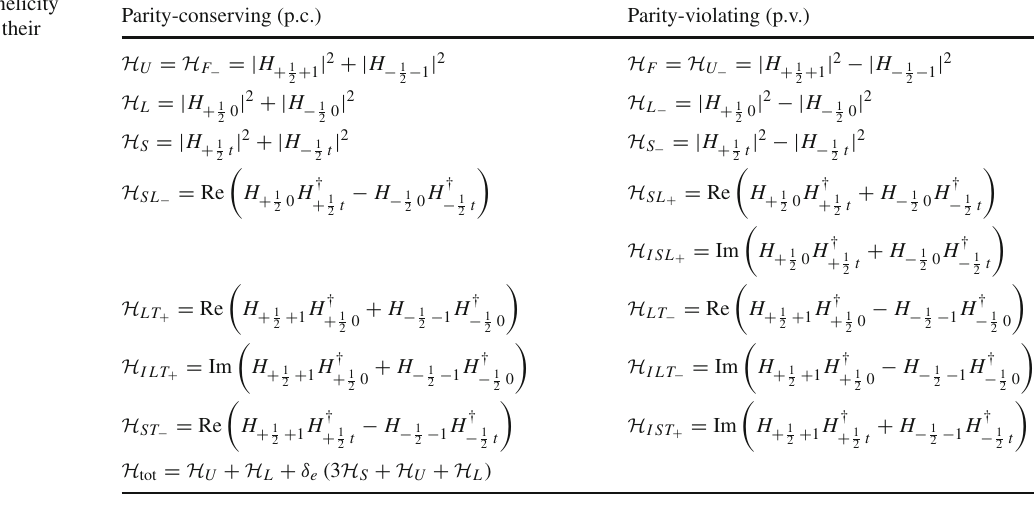
Table 1 Definition of helicity Parity-conserving (p.c.) Parity-violating structure functions and their parity properties